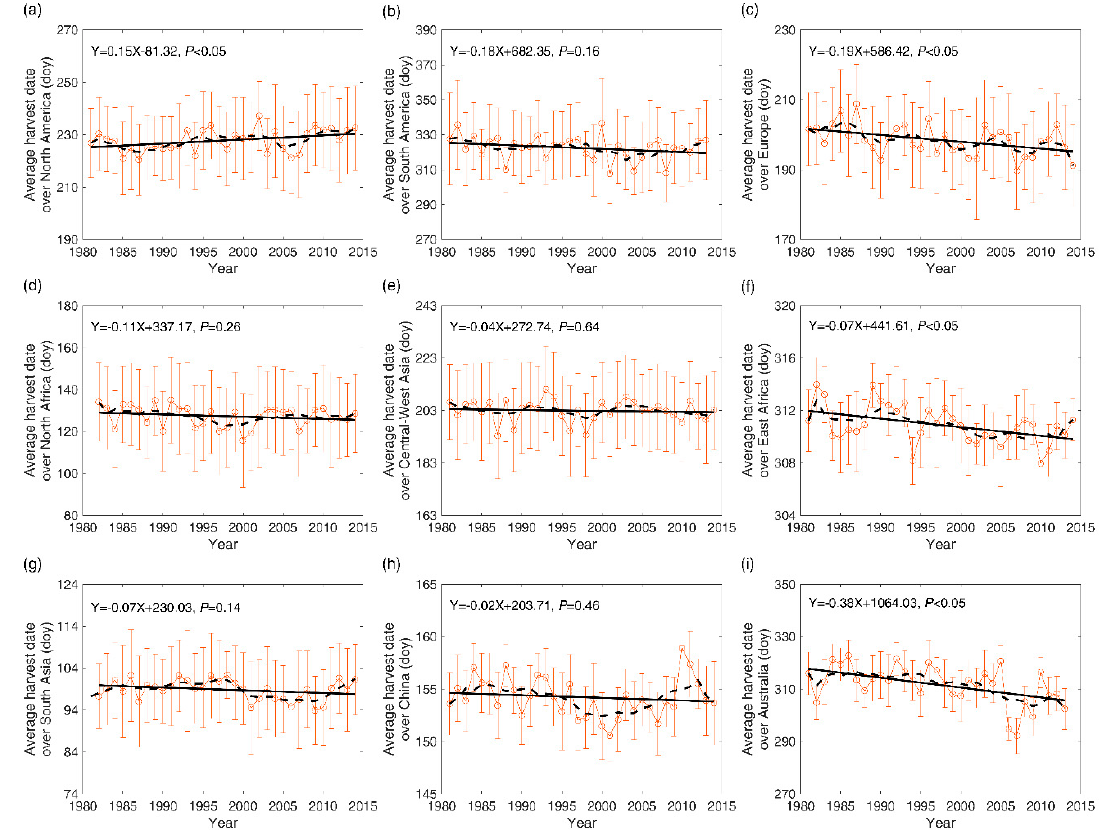
Figure 4. The WHD variation trends for nine wheat-planting areas. The solid black line indicates the linear trend, while the dashed black line indicates the 5-year moving average.